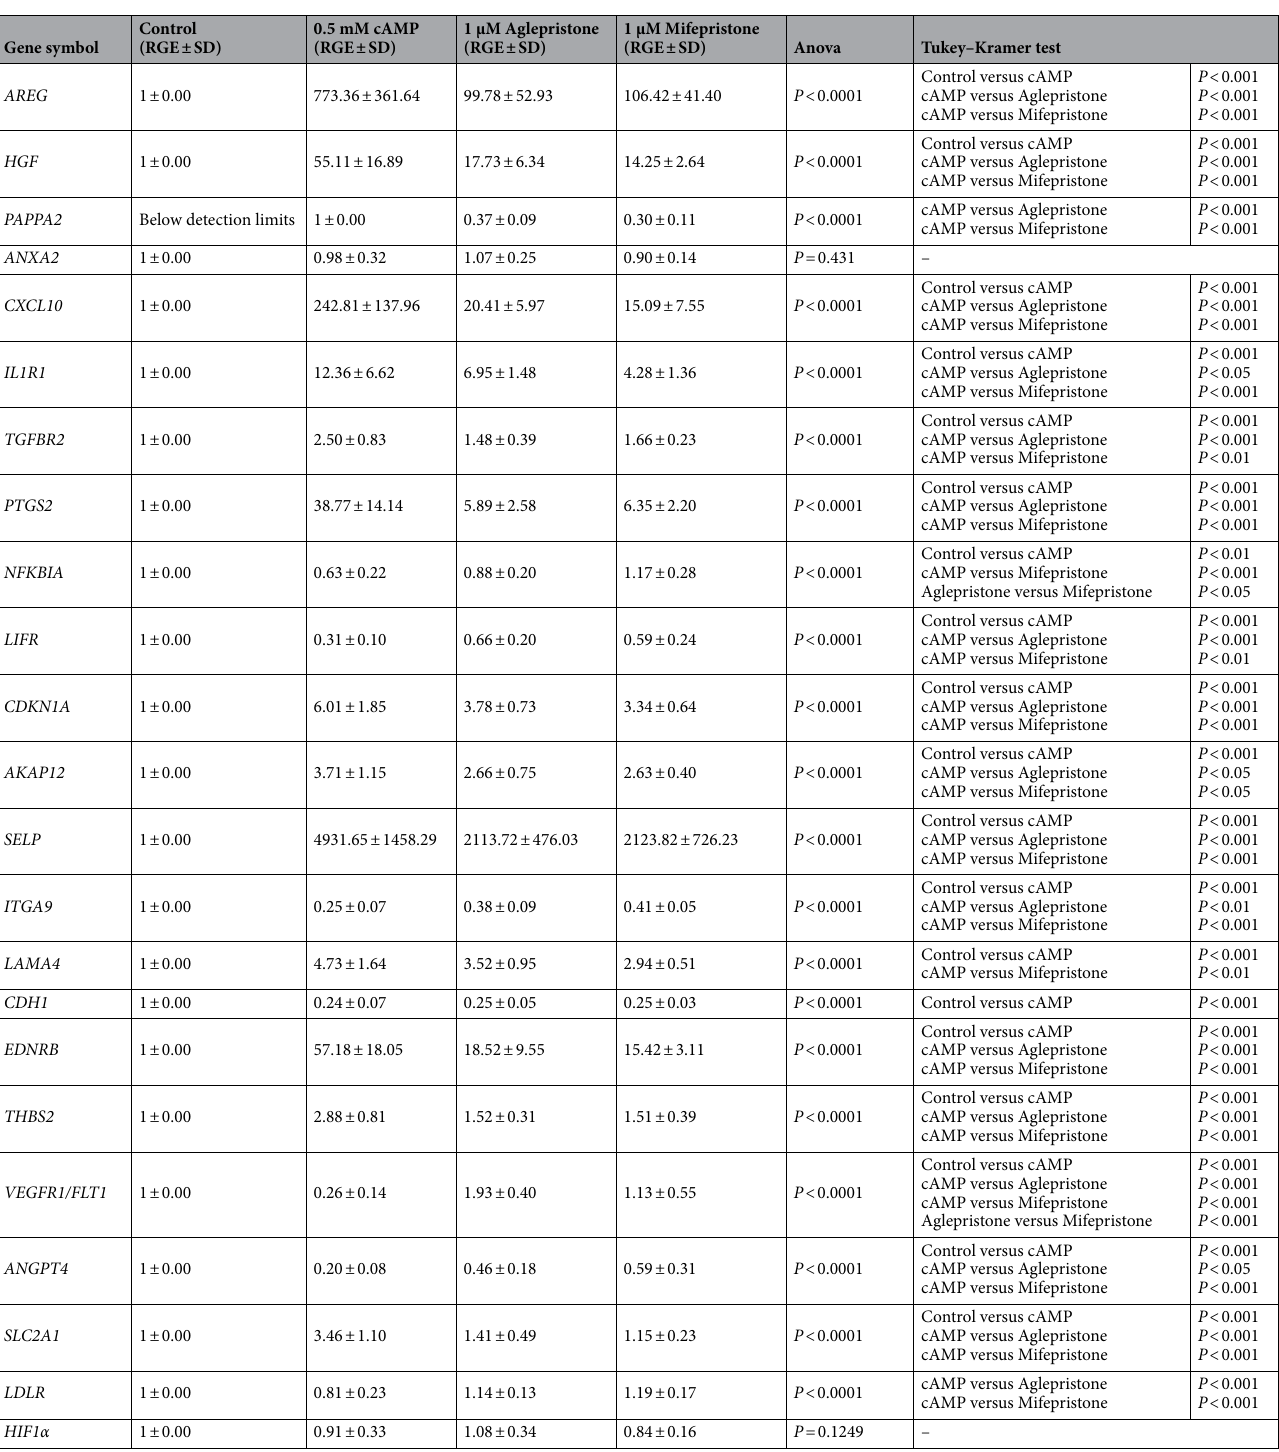
Table 1. Relative gene expression of selected candidate genes affected by different treatment conditions. Relative gene expression (RGE), as determined by semi-quantitative real-time TaqMan qPCR is presented as mean and standard deviation (SD). Differences between different treatment groups were evaluated with a non- parametric one-way ANOVA that, when P < 0.05, was followed by a Tukey–Kramer multiple-comparisons